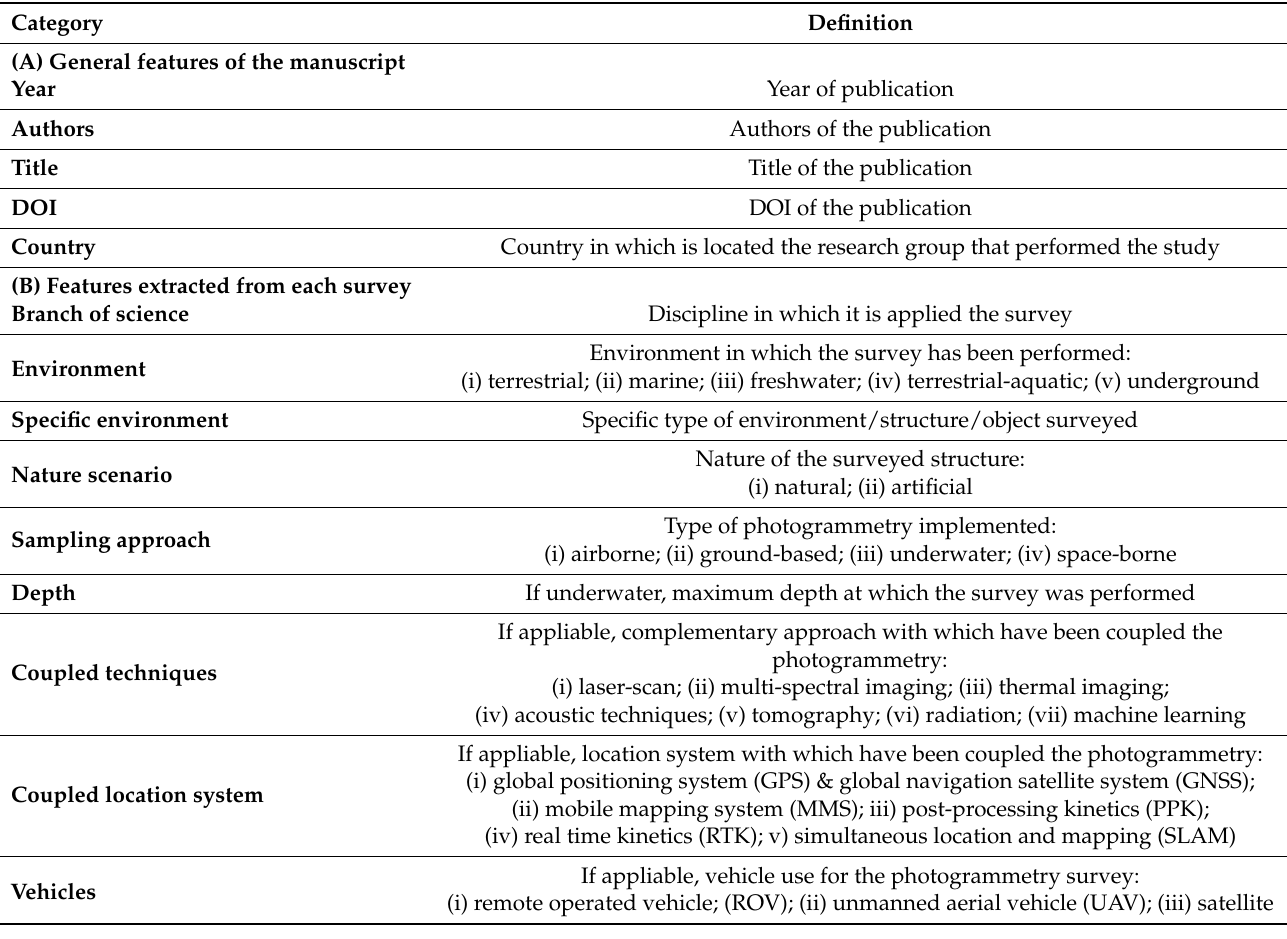
Table 2. Parameters used to classify photogrammetric surveys during the data